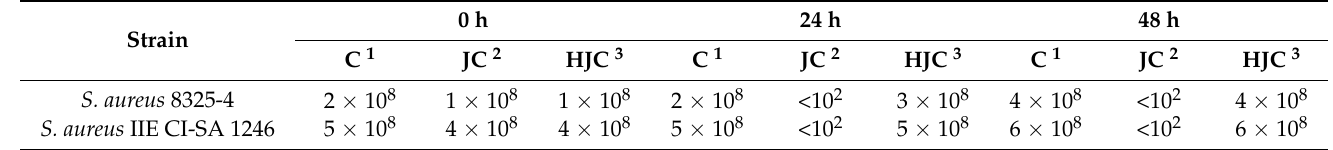
Table 2. Antagonistic activity of LF3872 against S. aureus strains.